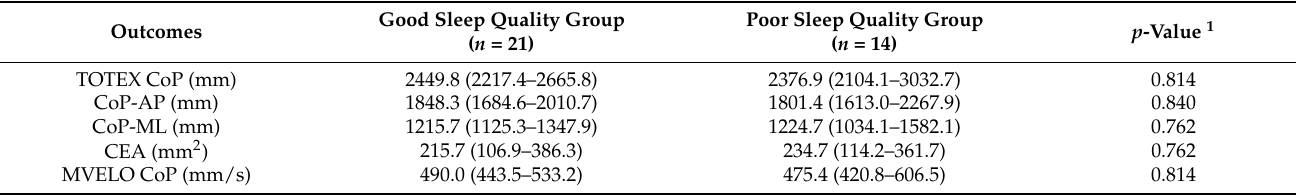
Figure 1. Statokinesigram: displacements of the center of pressure in anterior–posterior and medial–lateral directions during single task: ( a ) good sleep quality group; ( b ) poor sleep quality group ( p > 0.05). Table 2. Comparisons of center of pressure (CoP) behavior among good and poor sleep quality groups during standing posture task (single task), median